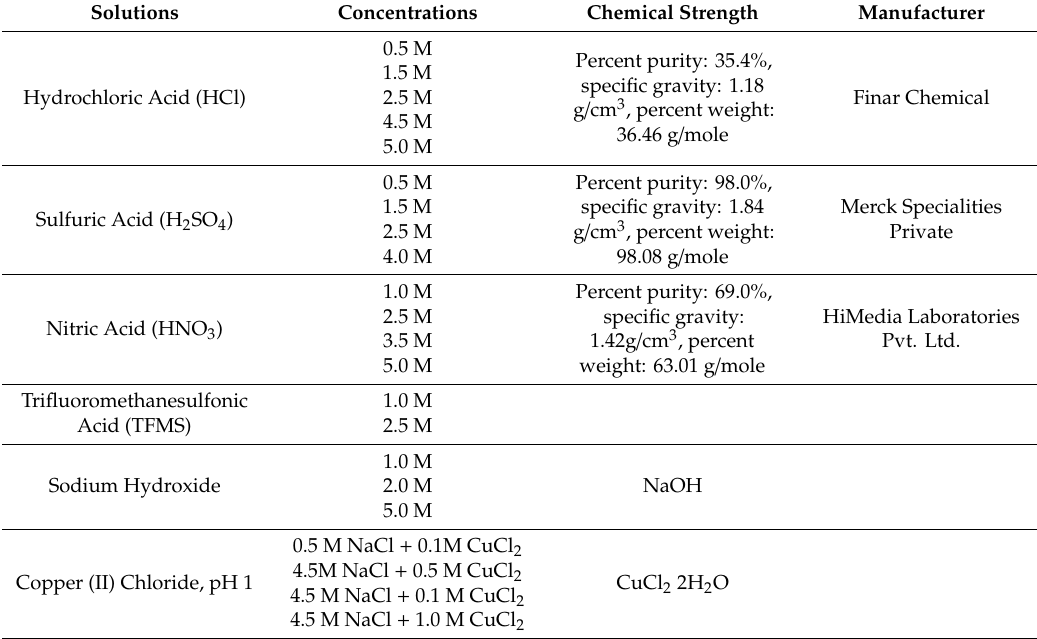
Table 2. Detailed information of the lixiviants used for the extraction